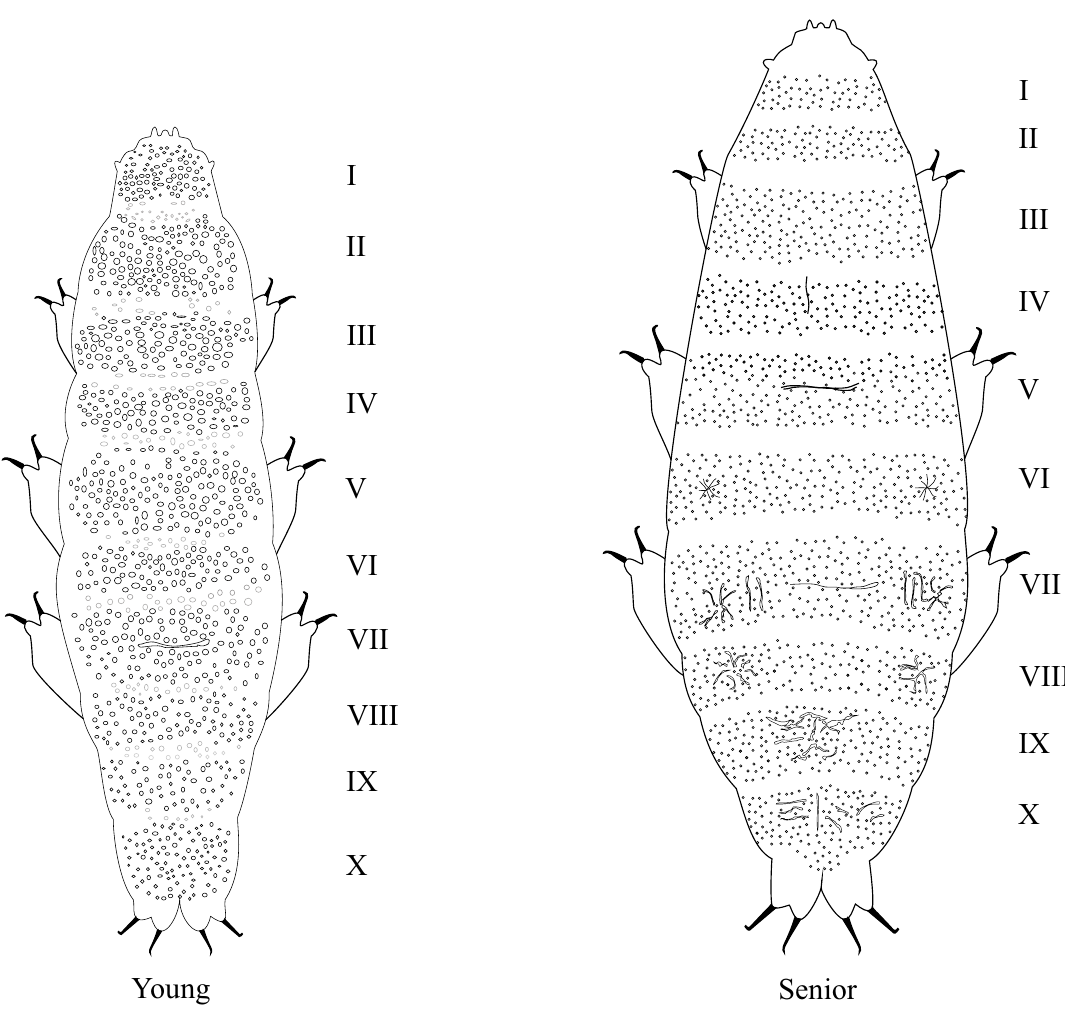
Fig. 1. Milnesium pelufforum sp. nov. Schematic drawing of a young and a senior specimen showing the ten sculptured